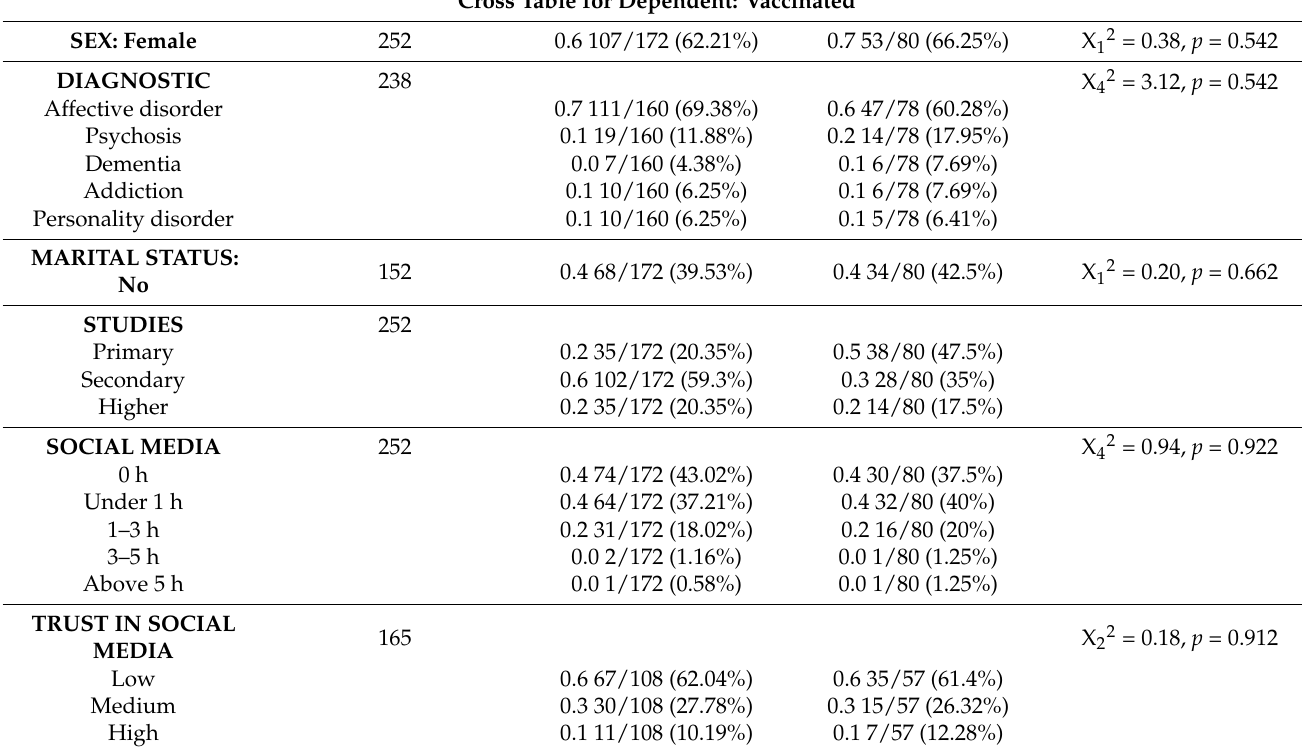
Table 1. Cont. Cross Table for Dependent: Vaccinated